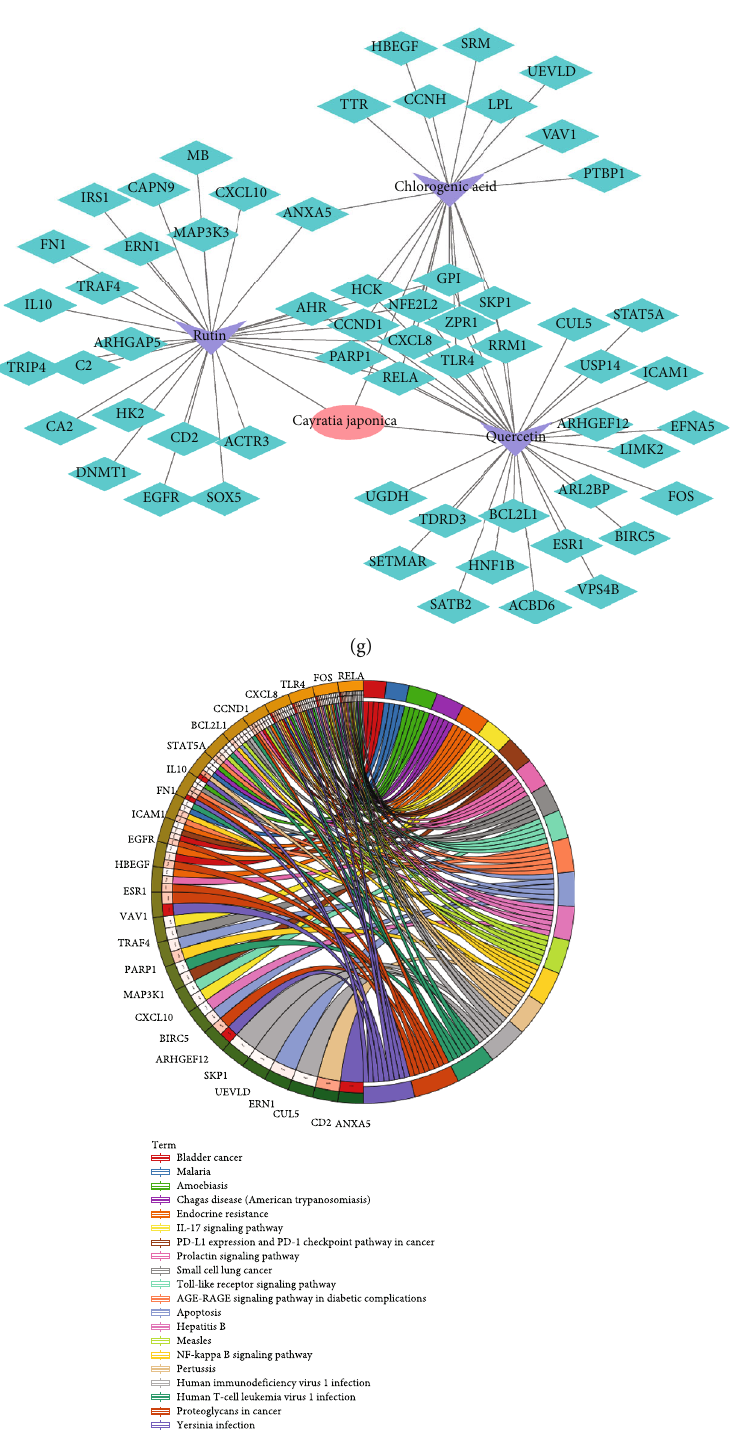
Figure 1: Pharmacological analysis of key targets of CJ in UC. (a) 3D pharmacophore of rutin, chlorogenic acid, and quercetin retrieved from the PubChem database. (b) Volcano map of di ff erentially expressed targets in dataset GSE48958 (control sample = 8 ; UC sample = 7 ). Red dots represent the upregulated genes. Green dots represent downregulated genes. (c) Volcano map of the di ff erentially expressed targets in the dataset GSE65114 (control sample = 12 ; UC sample = 16 ). (d) Venn map showing the intersection of di ff erentially expressed targets from the datasets GSE48958 and GSE65114 and the drug targets. (e) PPI network of 60 candidate targets. (f) Top 15 targets with highest degree values displayed in the PPI network. (g) The “ drug-component-target ” network map. (h) KEGG enrichment analysis of the 60 candidate targets. The targets are shown in the left while the pathways are shown in the right. Counterclockwise direction starting from RELA indicates less pathway